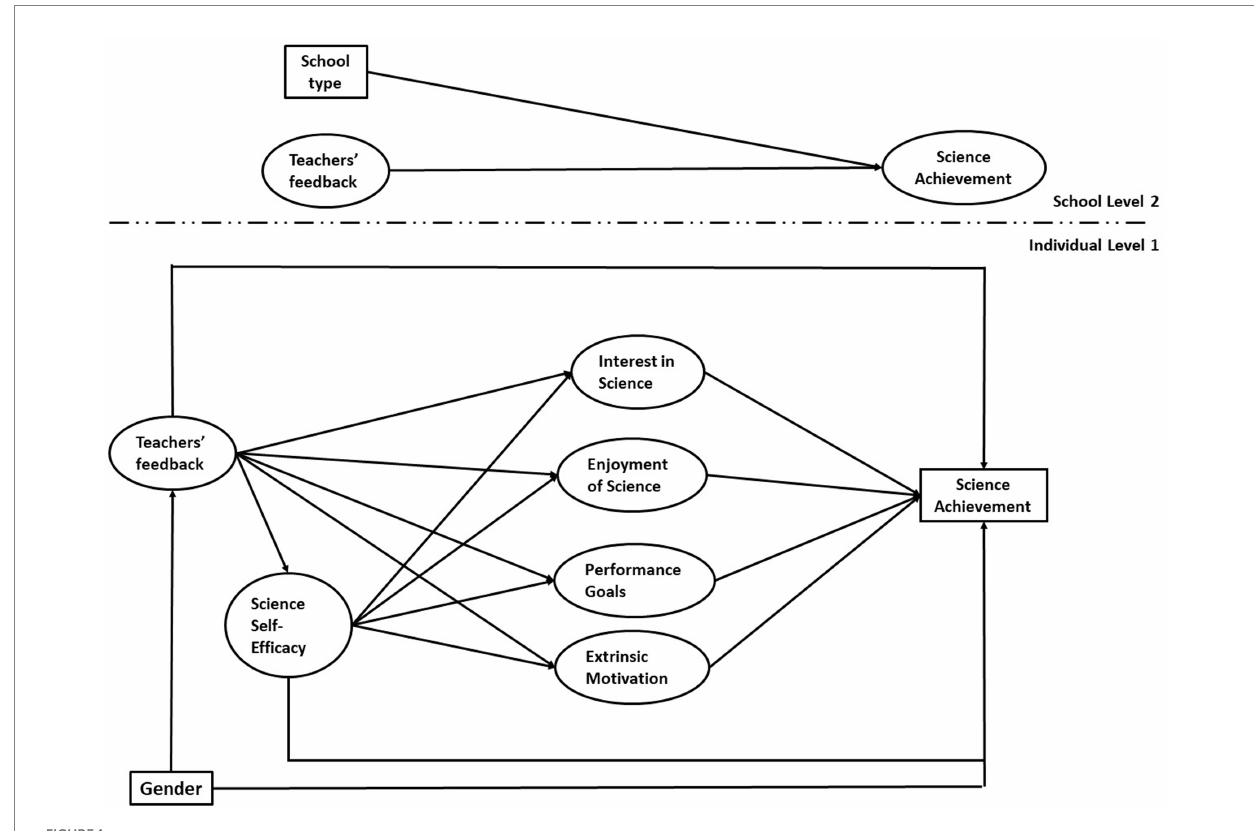
FIGURE 1 Diagram of the conceptual multilevel SEM